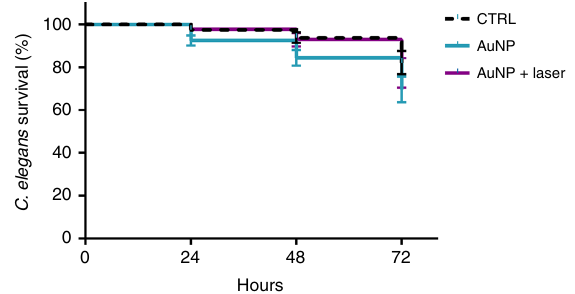
Fig. 9 In vivo toxicity assessment in Caenorhabditis elegans . Kaplan – Meier survival plot of Caenorhabditis elegans in the presence of OGM medium (CTRL), pristine 70 nm AuNP (AuNP), or laser-irradiated AuNP (AuNP + laser). Survival was assessed after 24, 48, and 72 h exposure (average ± SEM). No signi fi cant differences were found between the different groups. Each condition was tested in 4 biological repeats and each biological repeat consisted of 6 technical repeats ( n = 4 × 6). Statistical analysis